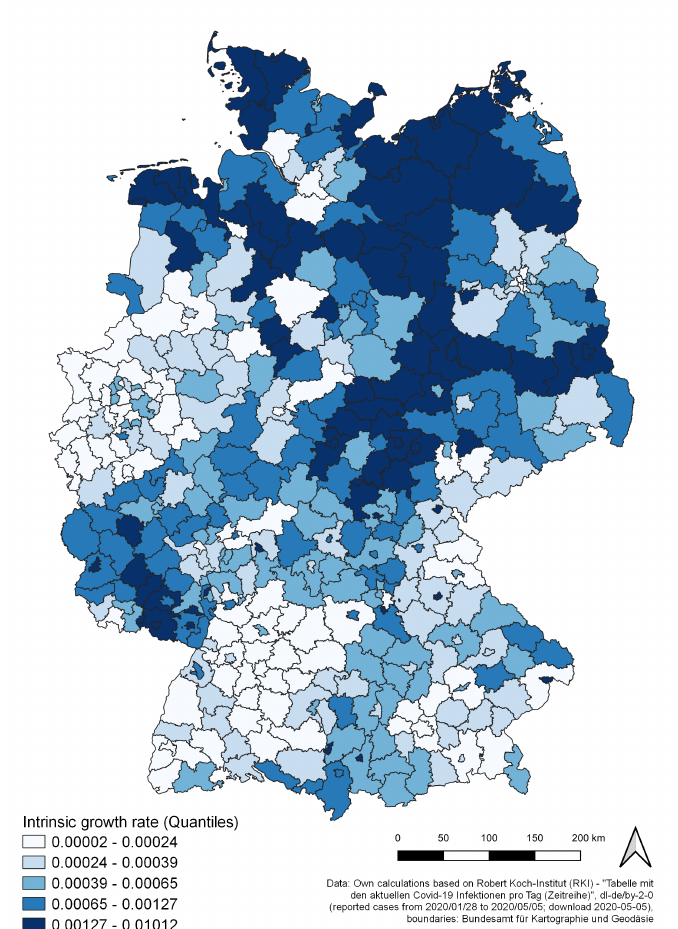
Figure 5: Intrinsic growth rate by